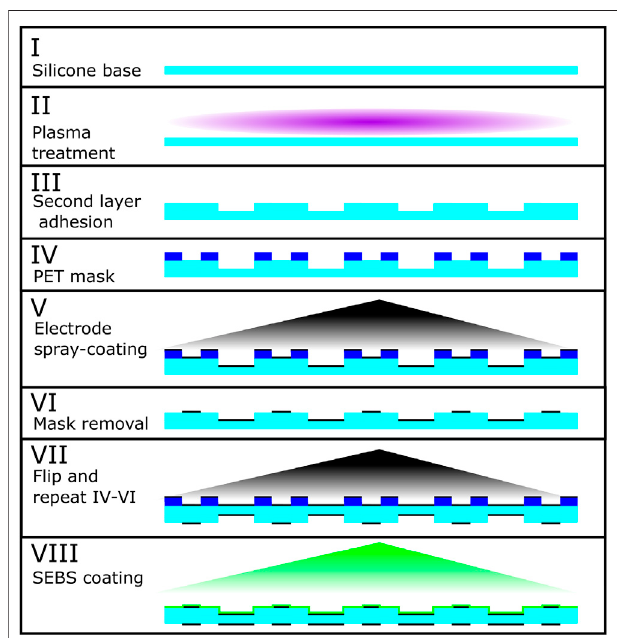
FIGURE 8 | Production of the PILA actuator. Starting at stage I with the silicone base layer (Wacker Elastosil ® 2030), this is plasma treated (II) to activate the surface for bonding with a similarly tre ’ ated second layer to produce the different thickness sections (III). A PET mask is used (IV) to selectively spray-coat the conductive electrode mixture onto the active areas (V). This process is then repeated on the other side for the ground electrodes (VII). Finally a thin layer of SEBS-g-MA (maleic anhydride grafted styrene- ethylene-butylene-styrene) co-block polymer is applied to reduce gas